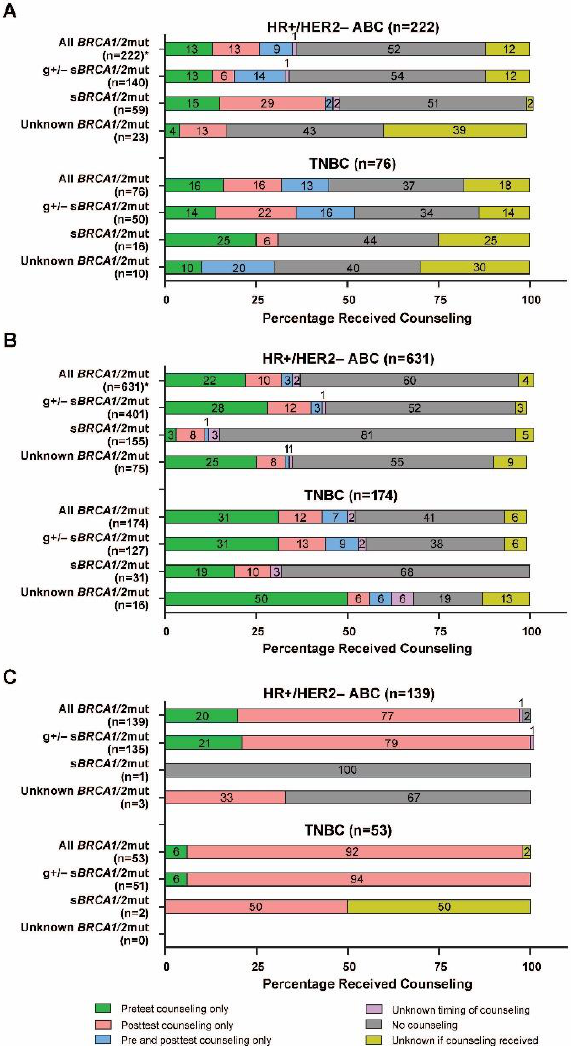
Figure 3. Receipt of genetic counseling by BRCA1/2 mut testing type among patients with HER2 − ABC in ( A ) the United States, ( B ) the EU4, and ( C ) Israel. Percentages may not add to exactly 100 because of rounding. * Indicates a statistically significant difference between those who had and did not have genetic counseling. ABC = advanced breast cancer; BRCA1/2 mut = breast cancer susceptibility gene 1 or 2 mutation; g = germline; EU4 = European Union 4 (France, Germany, Italy, and Spain); HER2 − = human epidermal growth factor receptor 2–negative; HR+ = hormone receptor–positive; s = somatic; TNBC = triple-negative breast